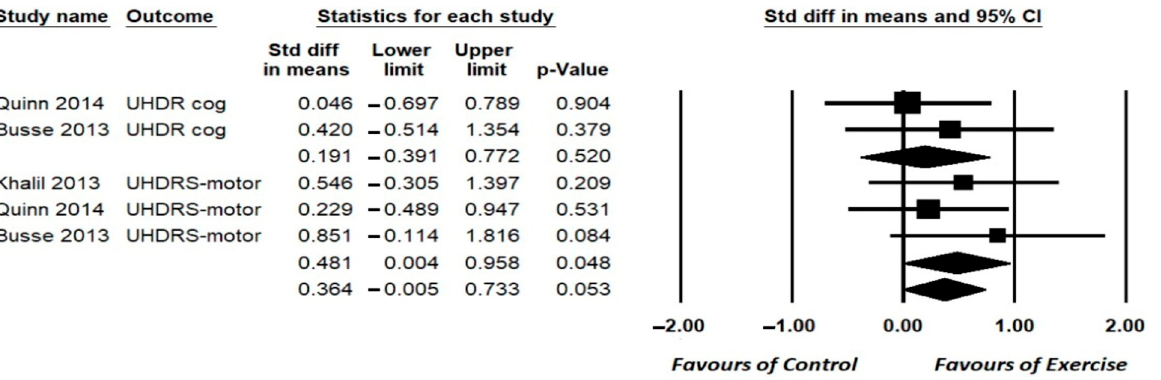
Figure 2. Forest plot for the effects of Home-based exercise (HBE) intervention compared with conventional interventions on Unified Huntington Disease Rating Scale (UHDRS) motor and cognitive sections [9,10,18]. CI, confidence interval.